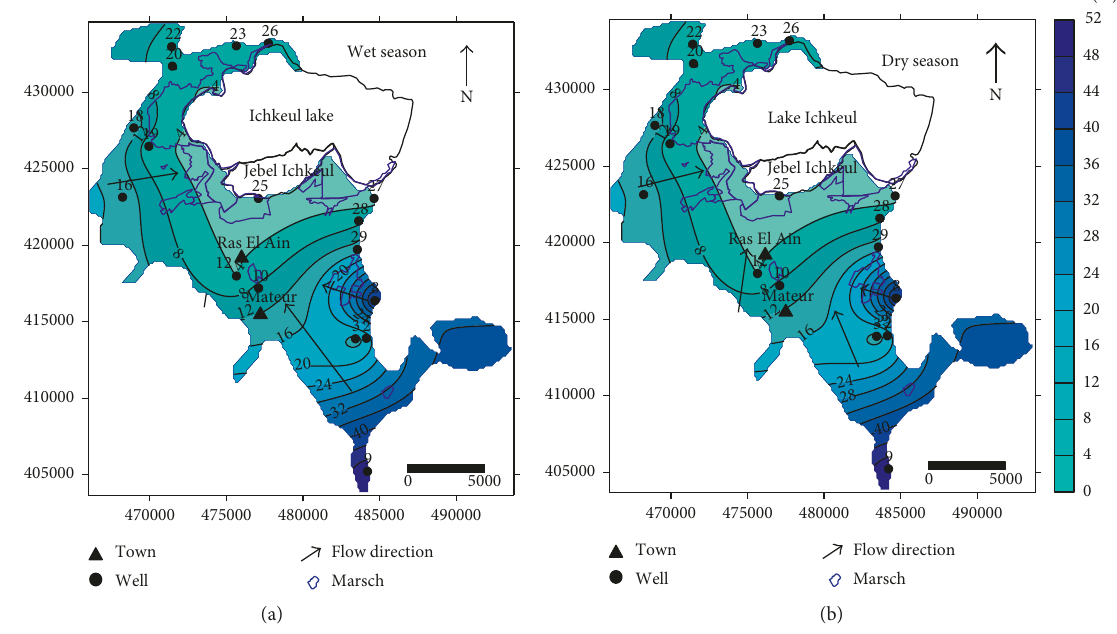
Figure 4: Piezometric maps of Mateur plain: (a) wet season and (b) dry season. Table 1: Details of fertilizer application for different crops in the study area.